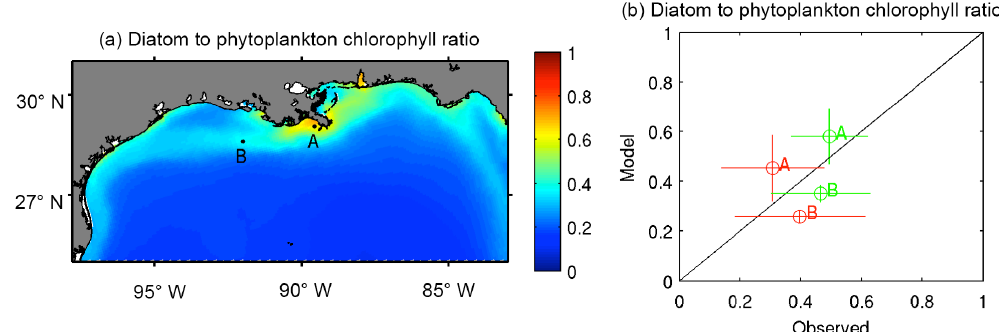
Figure 5. Chlorophyll ratios. (a) Climatological mean of the diatom-to-total-phytoplankton ratio of chlorophyll; (b) comparison between observations and model-derived diatom-to-total-phytoplankton ratio of chlorophyll in the Louisiana shelf (coastal stations A and B depicted in panel a ) during April (green) and August (red) of 2010–2012. Vertical and horizontal bars depict ± 1SD. Mean and standard deviation of observed chlorophyll ratio are derived from values reported by Zhao and Quigg (2014).